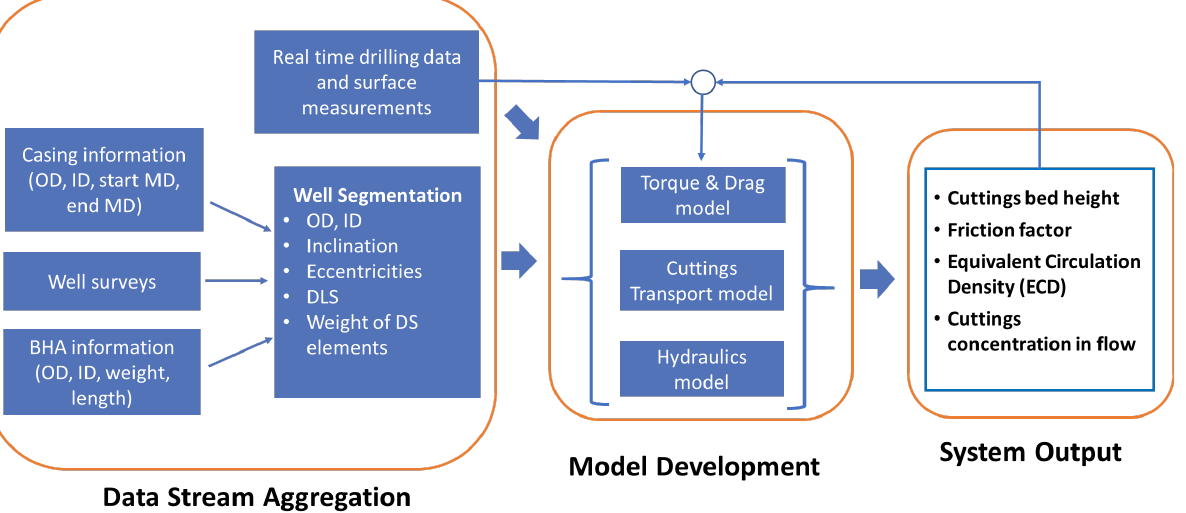
Figure 3. Final structure of the proposed digital twin for the hole cleaning system, see also [82].